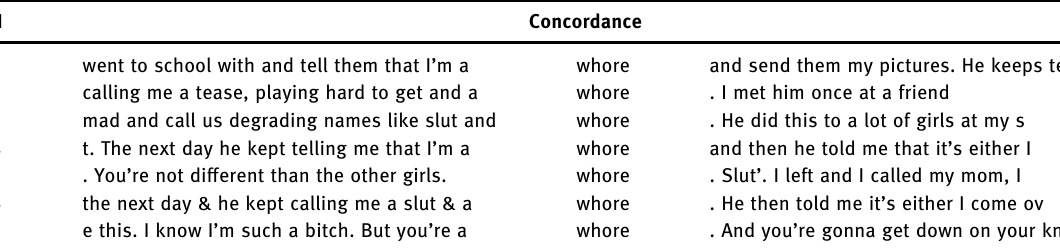
Table 22: Concordance lines for whore N